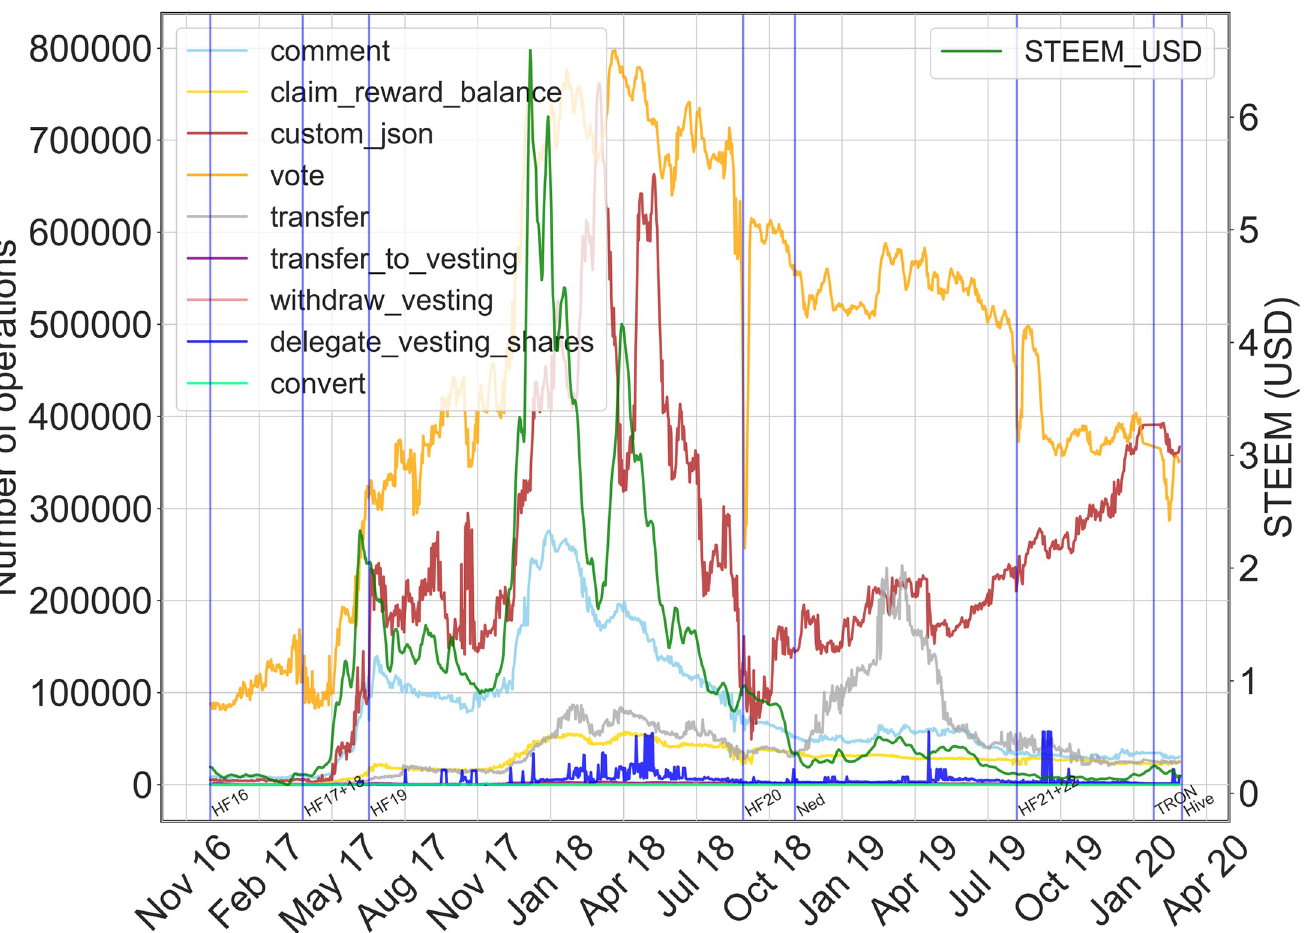
Fig 3. Social/Financial action time series and STEEM price. Time plots of the daily volume of social and financial operations along with the STEEM price in USD (green). On the x-axis: time in days. On the left y-axis: volume of operations per day (visualization of smoothed values, with a running average window of 7 days). On the right y-axis: STEEM price in USD. The blue vertical lines correspond to important events, like hard forks (HFXX), the crisis announcement by Scott (Ned)— Steemit founder, the selling of the company to TRON Foundation (TRON) and the Hive fork (Hive), which corresponds to the end of the observation period.